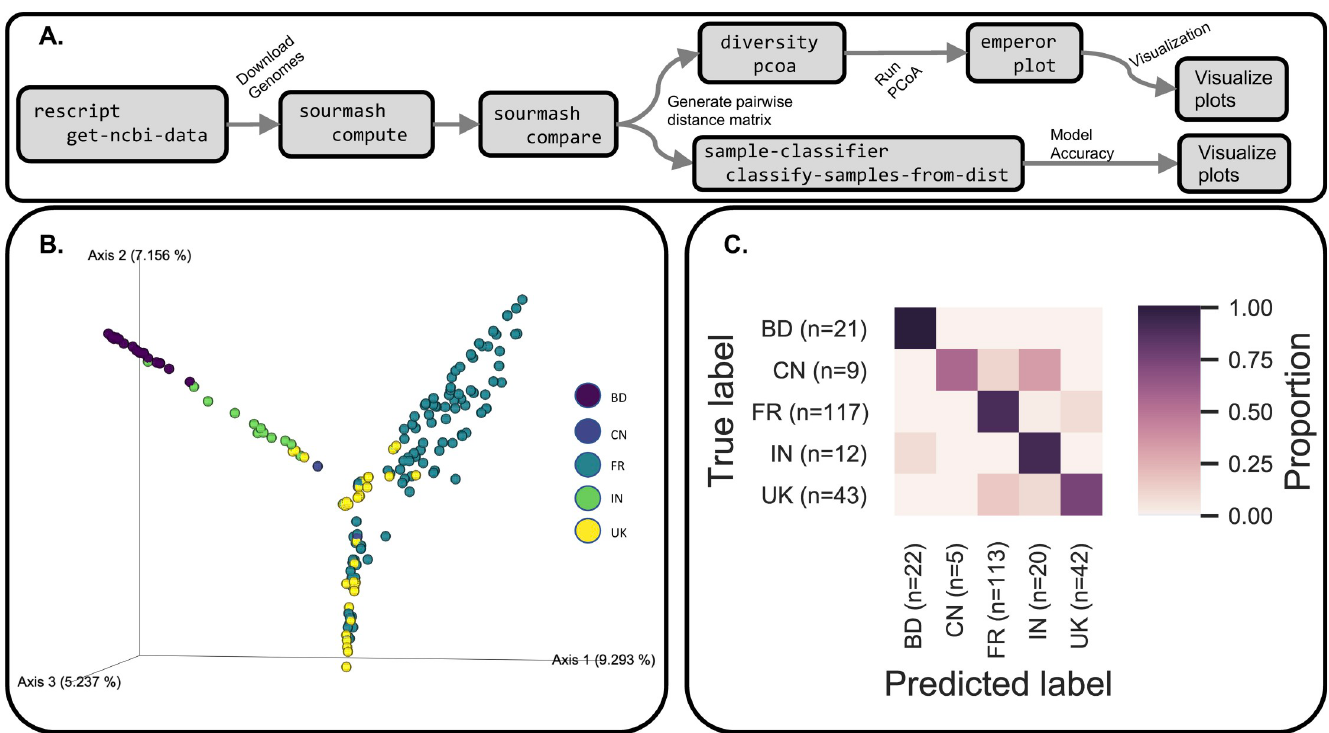
Fig 14. An example of using RESCRIPt for reproducible genomics workflows. HEV genomes were downloaded from NCBI-GenBank and used to make a reference genome classifier based on the following geographic locations: Bangladesh (BD), China (CN), France (FR), India (IN), and the United Kingdom (UK). The interoperability of RESCRIPt with other QIIME 2 plugins enables users to chain together a variety of functions into fully reproducible workflows that record processing decisions in data provenance. A, a simplified data provenance graph highlighting our workflow leveraging RESCRIPt, q2-sourmash, q2-diversity, q2-sample-classifier, and EMPeror. B, PCoA plot of individual HEV genomes based on MASH signature comparison results. C, k-nearest-neighbor classification accuracy based on MASH signature dissimilarities and geographic location.